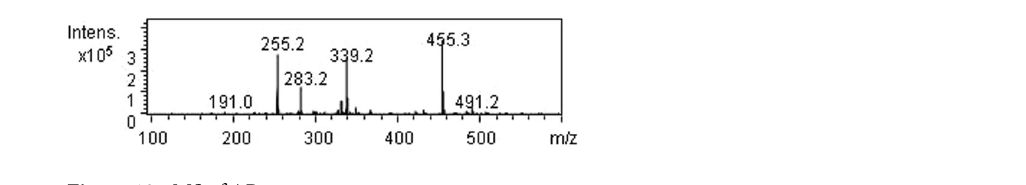
Figure 10. MS of AP.